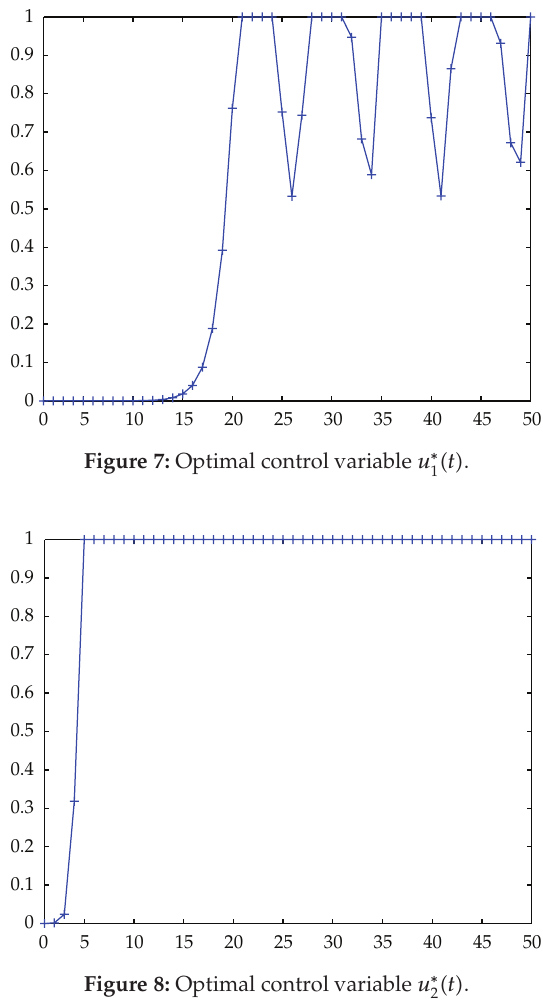
Figure 8: Optimal control variable u ∗